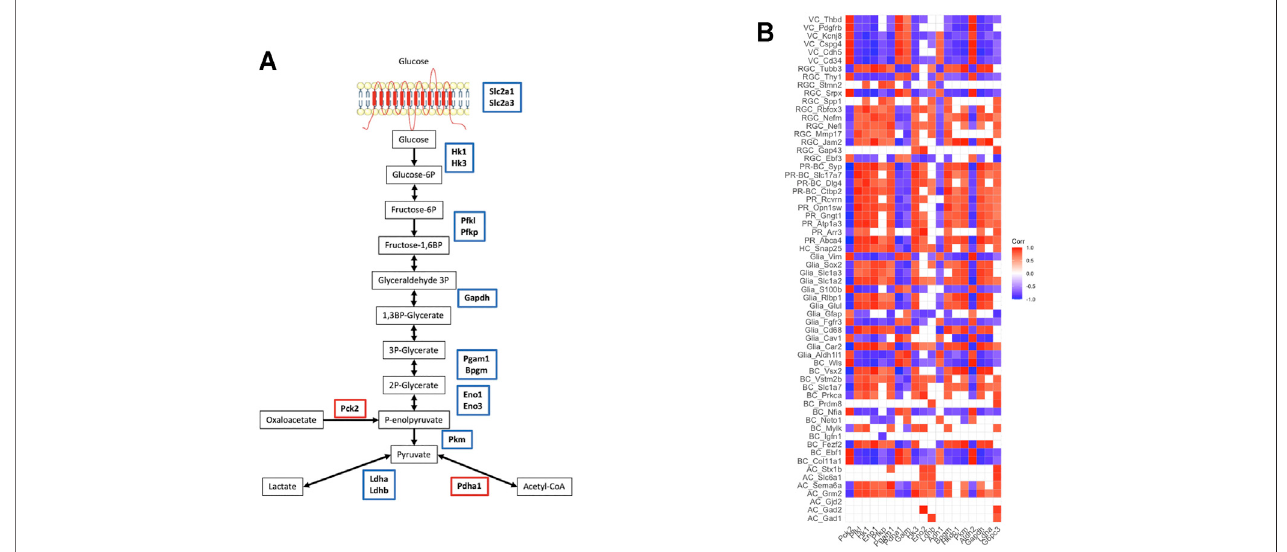
FIGURE 4 | Metabolic changes after starvation exposure: (A) glycolysis pathway — the genes encoding the enzymes functioning in the pathway were downregulated, (B) the correlation between retinal cell markers and glycolysis/gluconeogenesis genes (VC: vascular cells, RGC: retinal ganglion cells, PR-BC: photoreceptor-bipolar cell synapses, PR: photoreceptor cells, HC: horizontal cells, BC: bipolar cells, AC: amacrine